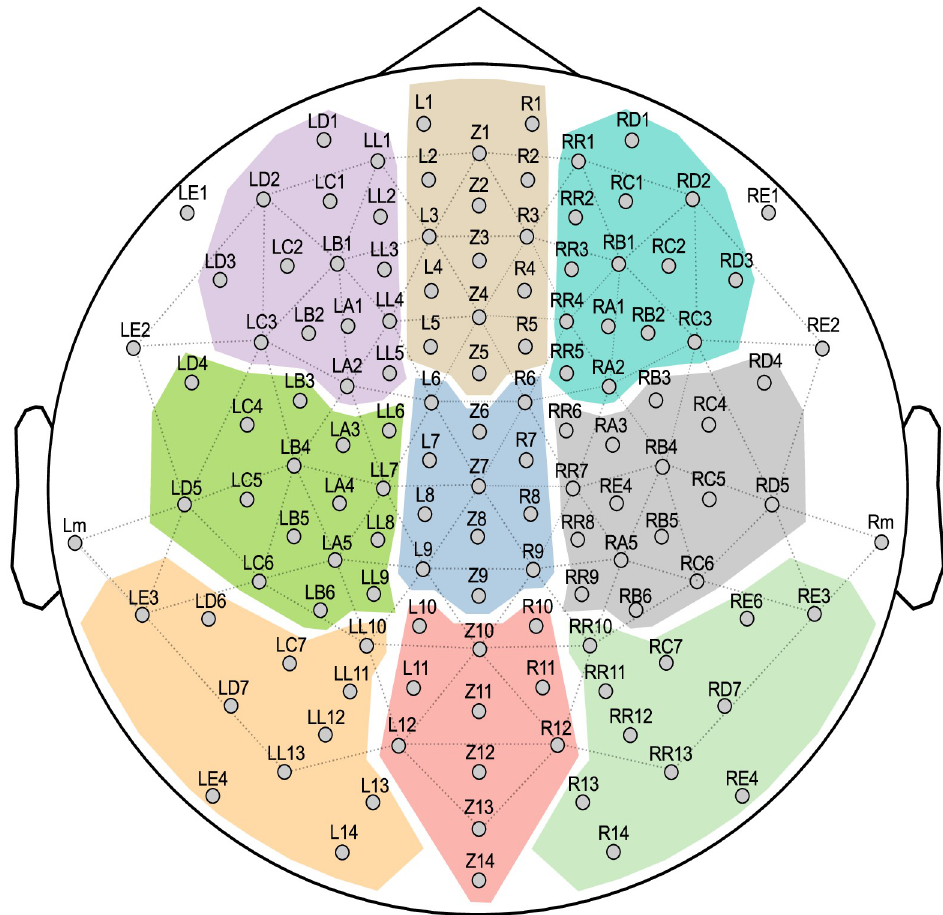
Fig 1. Definition of ROI in terms of electrodes. Note that electrodes LM, LE1, LE2, RM, RE1 and RE2 were excluded from the analyses.